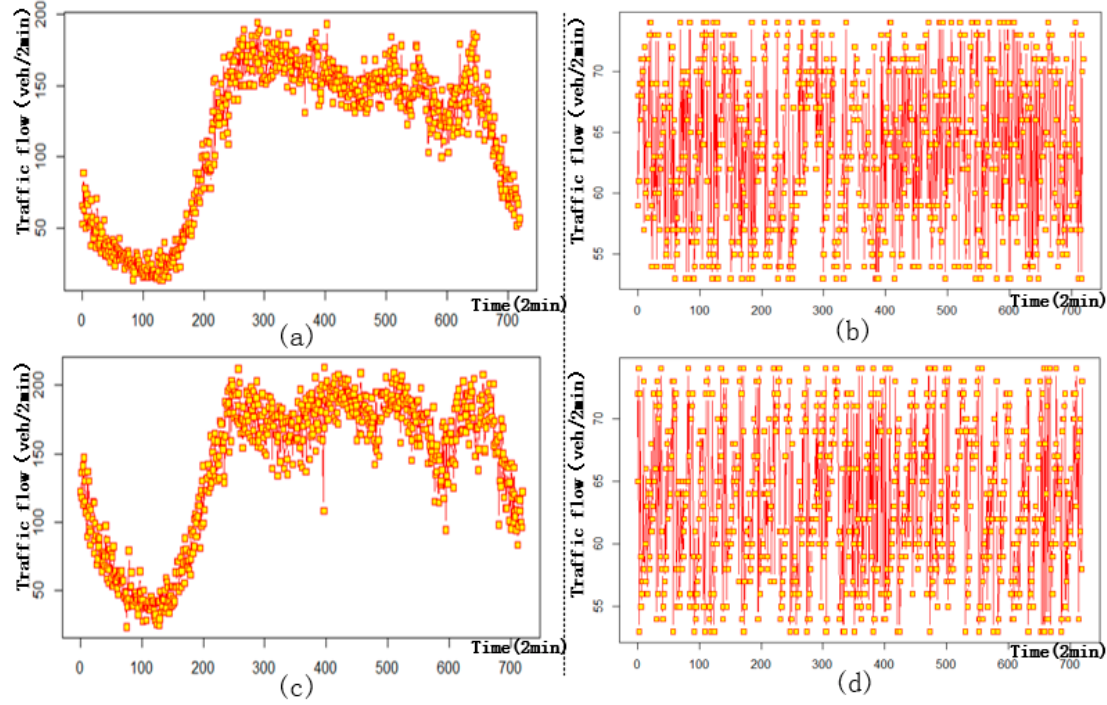
Figure 2 . Time series of traffic flow on 1 June 2015. ( a ) #3-2 sensors on the 3rd ring expressway; ( b ) #5-20 sensor on the 5th ring expressway; ( c ) #3-32 sensors on the 3rd ring expressway; ( d ) #5-66 sensor on the 5th ring expressway.